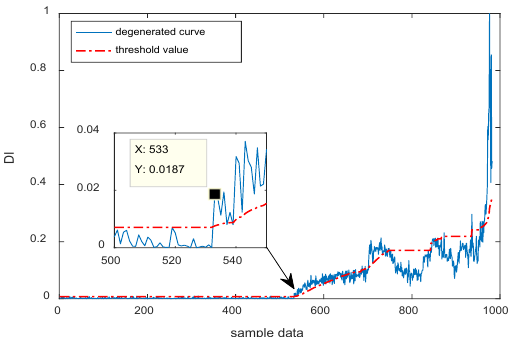
Figure 15. Degradation index based on LLE-SVDD.